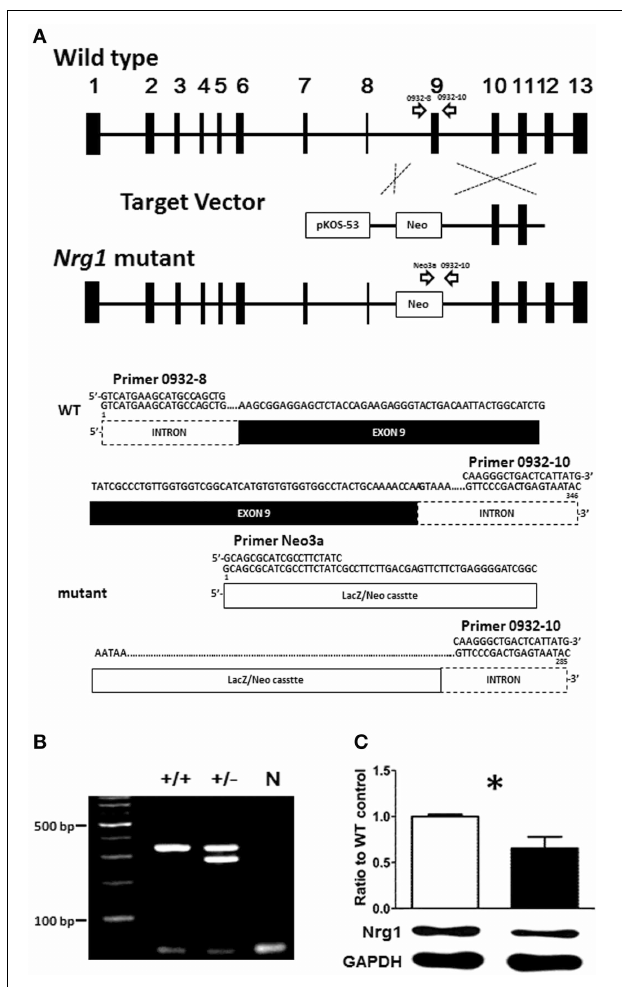
FIGURE 1 | (A) Schematic diagram of the targeting strategy for the novel TMc- Nrg1 + / − mutant mice. Upper panel, wild type (WT) Nrg1 locus including 13 exons, shown as black boxes. The target vector, pKOS-53 with a LacZ/Neo cassette, was targeted to exon 9 of Nrg1 by homologous recombination. Lower panel, primer 0932-8, primer 0932-10, and primer Neo3a were used to distinguish WT alleles (346bps) from mutant alleles (258bps). (B) Mouse-tail DNA was submitted to PCR analysis. N: negative control. (C) The expression level of Nrg1 proteins in the brain of both WT and Nrg1 + / − mice. ∗ P < 0 . 05 between two